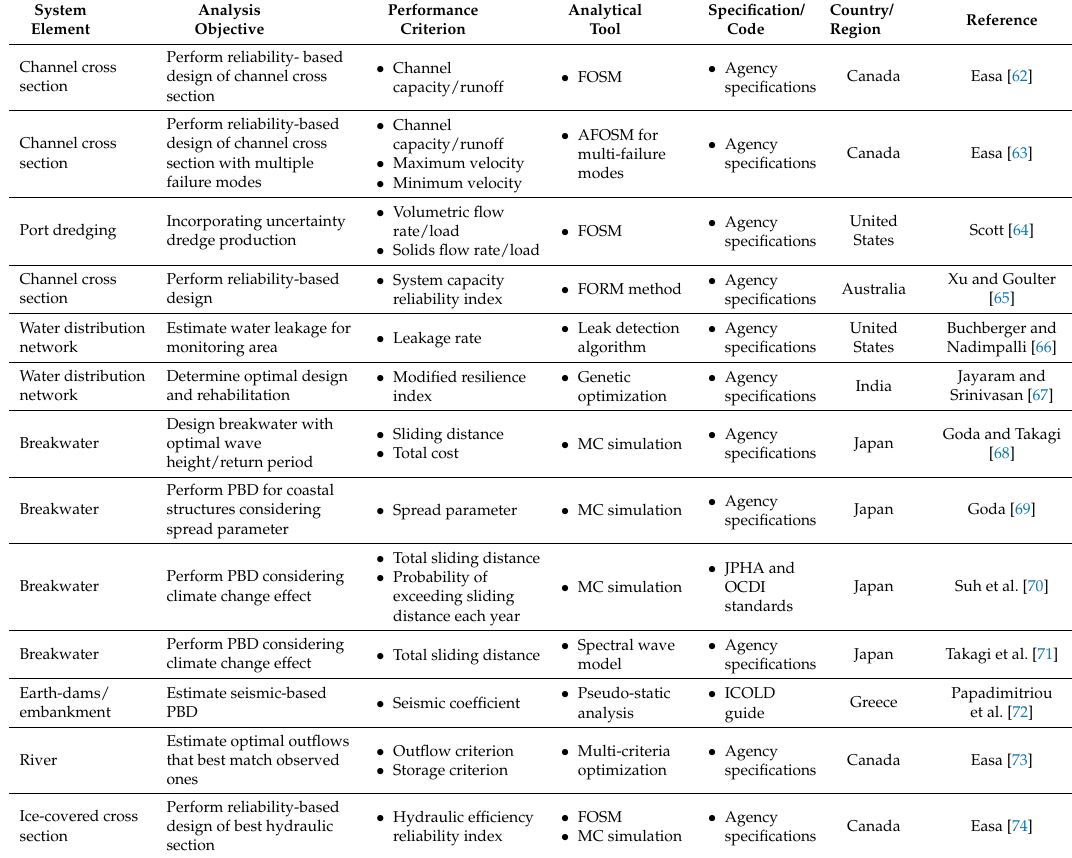
Table A4. Characteristics of water-structures design and operation